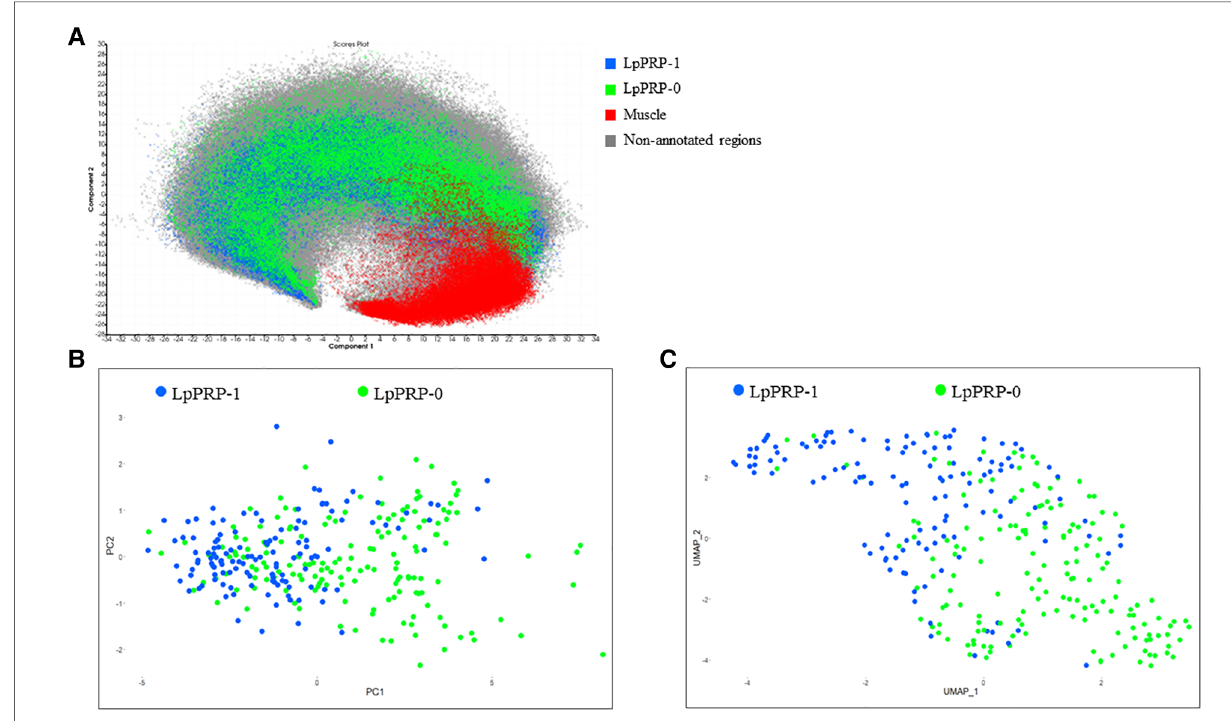
FIGURE 1 ( A ) Principal component analysis of the whole TMA dataset performed with SCiLS Lab software. Spectra from annotated regions of LpPRP-1 (blue) and LpPRP-0 (green) from all TMAs cluster together and are separated from muscle tissues (red). All muscle spectra (red) from all TMAs cluster in the same group. Each pixel corresponds to 1 spectrum. Principal component analysis ( B ) and UMAP analysis ( C ) of the annotated regions including spectra with m / z signals having an AUROC ≥ 0.7 show two clusters corresponding to LpPRP-0 (pixels in green) and LpPRP-1 (pixels in blue). PCA and UMAP were performed on patients, thus each pixel corresponds to one patient. UMAP analysis shows better separation of LpPRP-1 and LpPRP-0 patients. UMAP parameters used: n_neighbors=2, min_dist=0.3. TMA, tissue microarray; AUROC, area under the ROC curve; PCA, principal component analysis; LpPRP, leukocyte-poor platelet-rich plasma; UMAP, Uniform Manifold Approximation and Projection; ROC, receiver operating